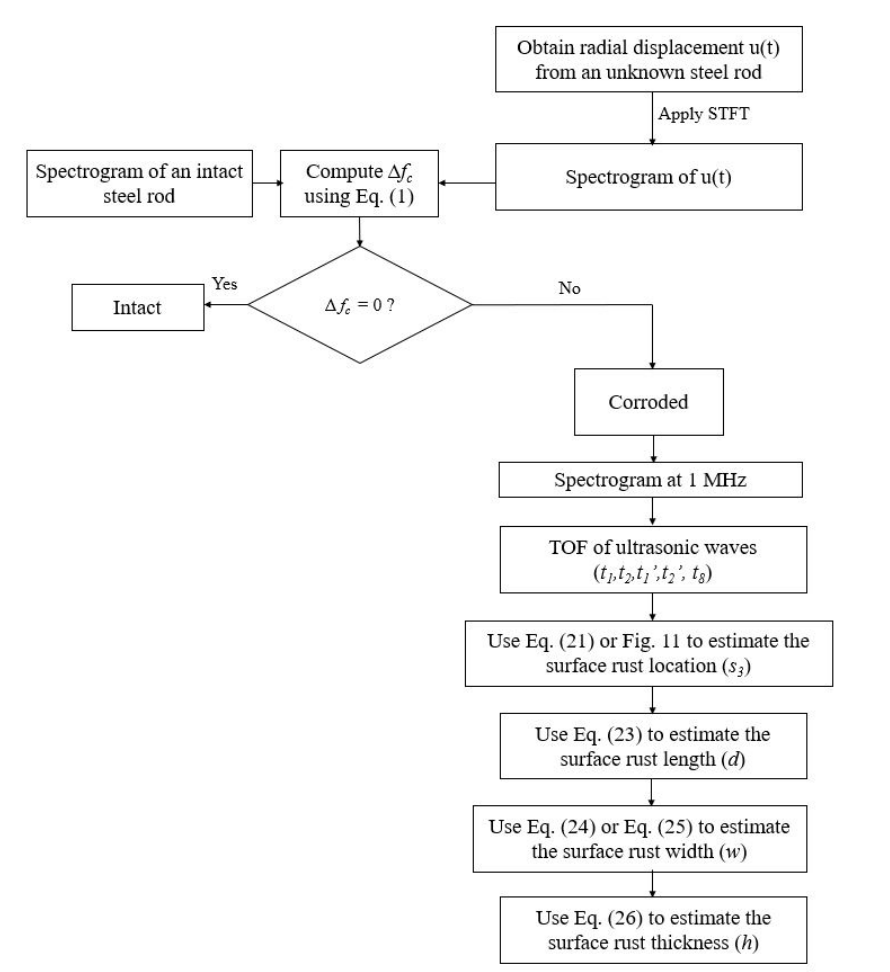
Figure 14. Surface rust detection